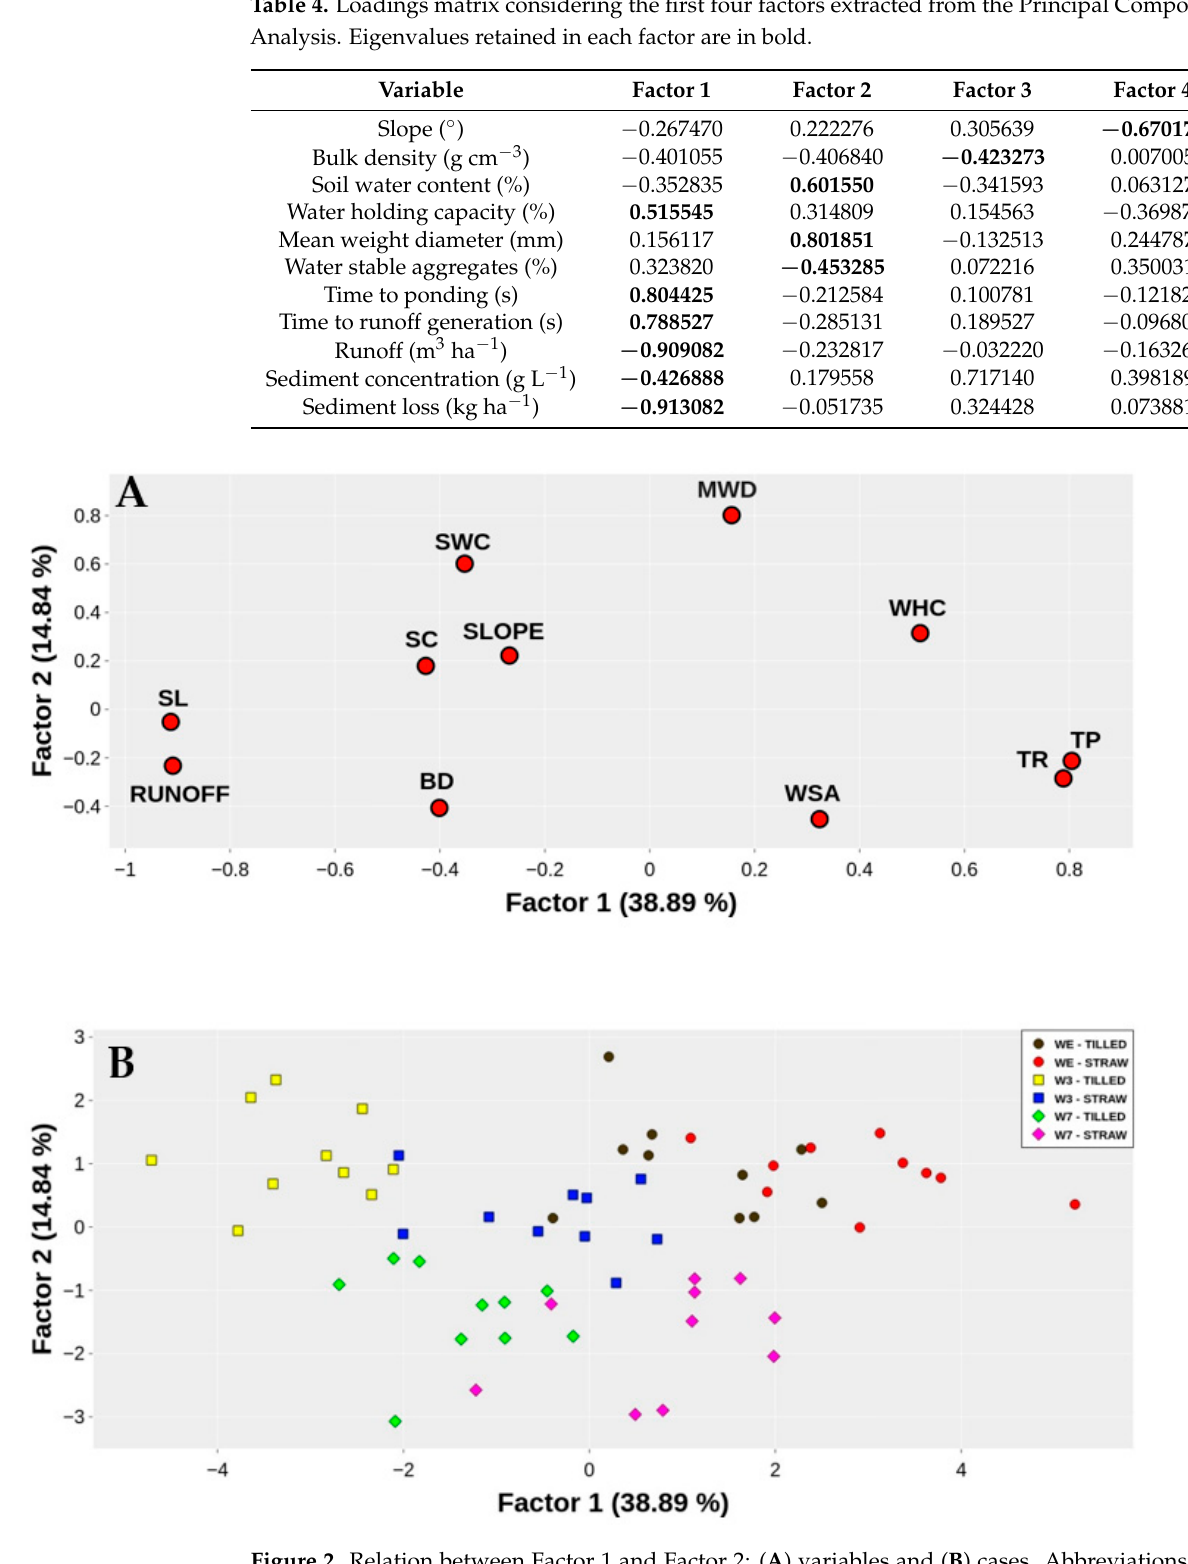
Figure 2. Relation between Factor 1 and Factor 2: ( A ) variables and ( B ) cases. Abbreviations: BD indicates bulk density; SWC, soil water content; WHC, water holding capacity; MWD, mean weight diameter; WSA, water stable aggregates; TP, time to ponding; TR, time to runoff generation; SC, sediment concentration; SL, sediment loss; SWC, soil water content. WE—after seeding; V3—five leaves stage; V5—intensive vegetative growth.